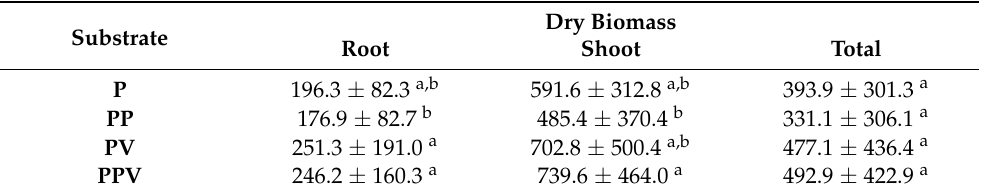
For the same column, averages with the same letter are not significantly different ( p >